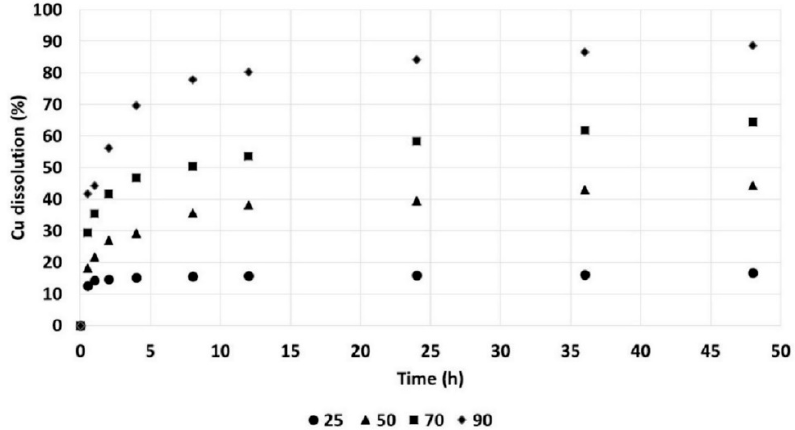
Figure 11. The dissolution of copper from copper sulphide ores without pretreatment in 0.2 M of H 2 SO 4 and 50 g/L of Cl − in deionized water at 25 °C ( ● 25), 50 °C ( ▲ 50), 70 °C ( ■ 70), and 90 °C ( ♦ 90).